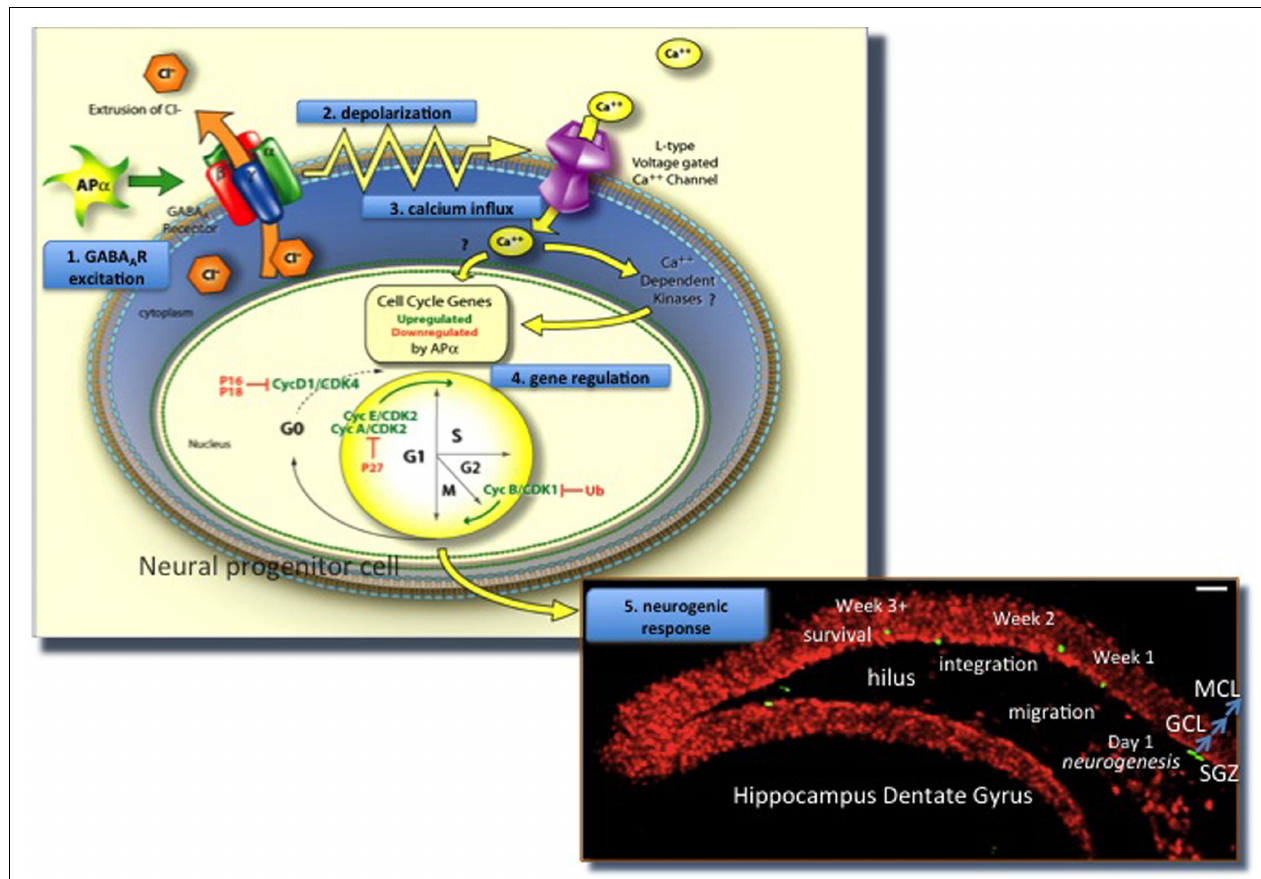
FIGURE 1 |Allopregnanolone (AP α ) mechanism of action promotes neurogenesis. (1) AP α activates the GABA type A receptor to initiate the efflux of chloride ions (Cl − ) from neural progenitor and neural stem cells. (2) Extrusion of Cl − from the intracellular compartment leads to membrane depolarization and activation of the voltage dependent L-type calcium channel. (3)The intracellular calcium (Ca ++ ) rise activates Ca ++ dependent kinases that ultimately lead to regulation of gene expression and protein synthesis of cell cycle proteins. (4) Involving the transcription factor cyclic AMP response element binding protein (CREB) signaling pathway, AP α up-regulates the expression of cell cycle genes that promote neural progenitor mitosis while simultaneously down regulating genes that repress cell division. (5)The mechanism of AP α -induced neurogenesis takes advantage of the developmentally regulated direction of Cl − flux to induce neurogenesis in those cells that are phenotypically competent to divide while not activating